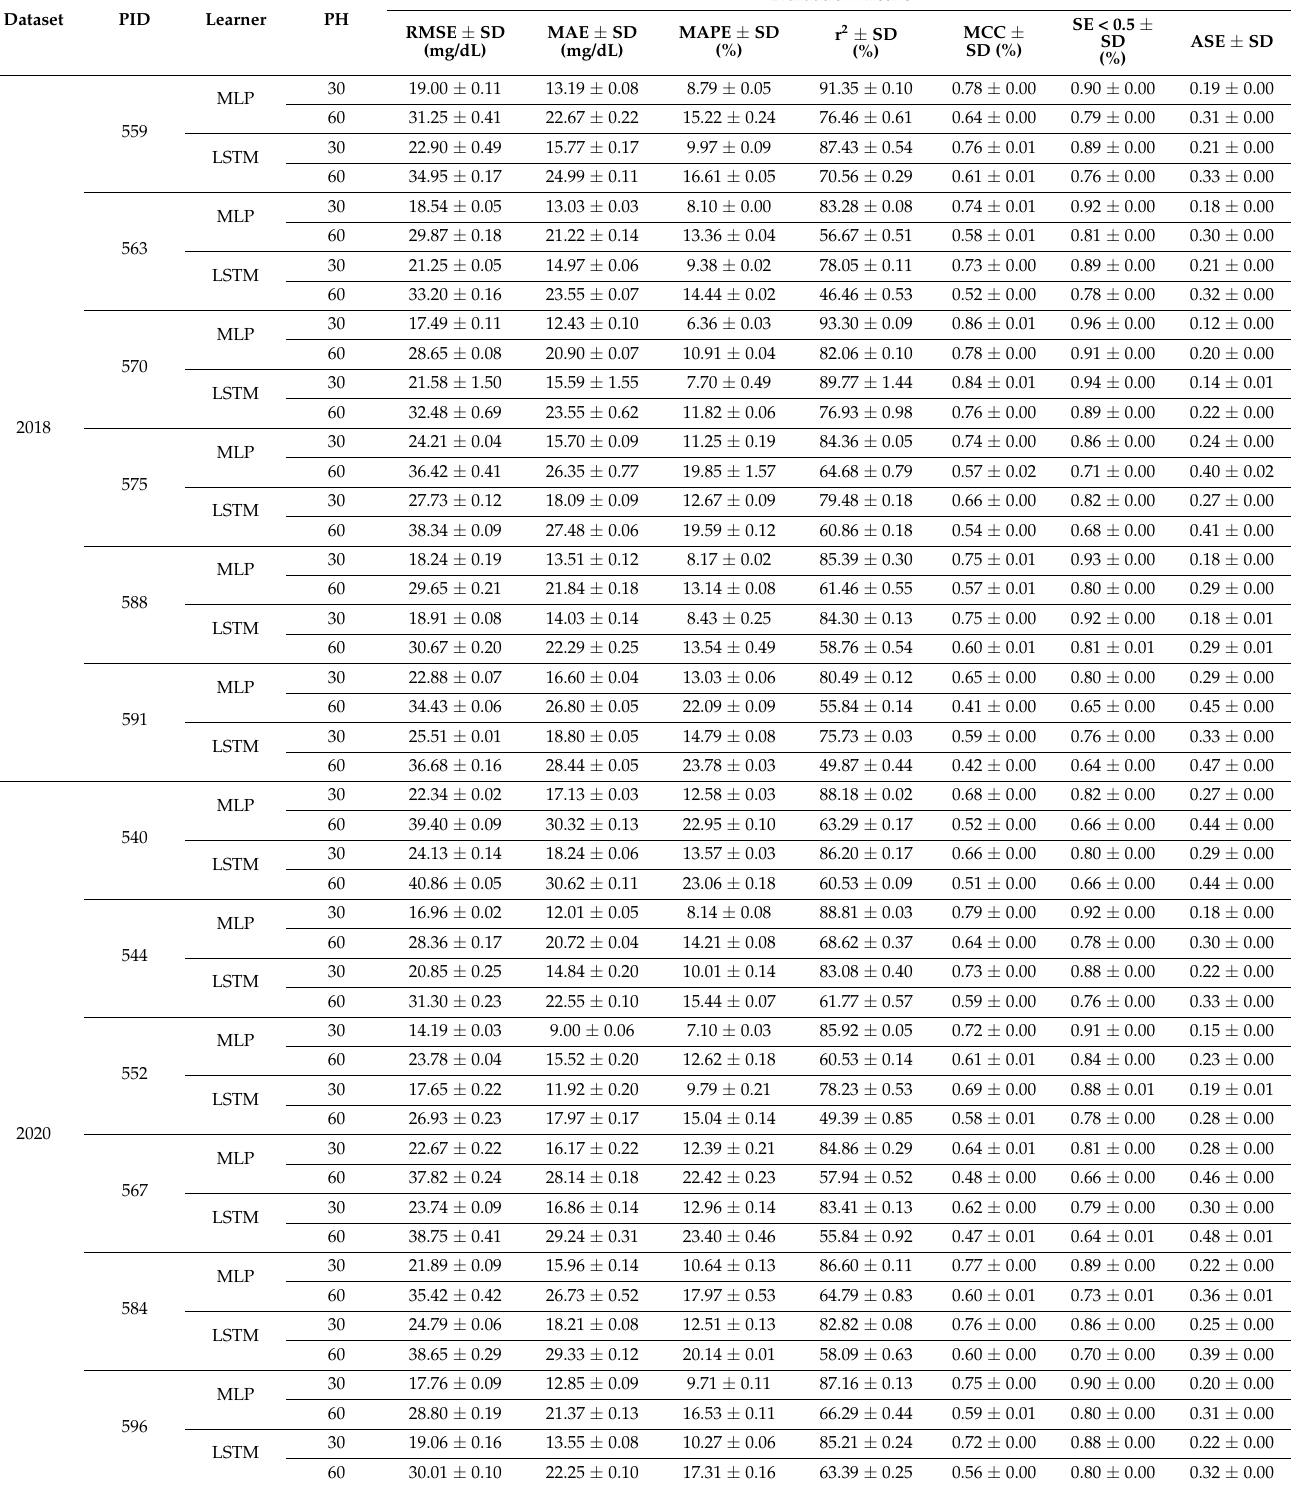
Table 3. The evaluation results for the stacking models created using Ohio